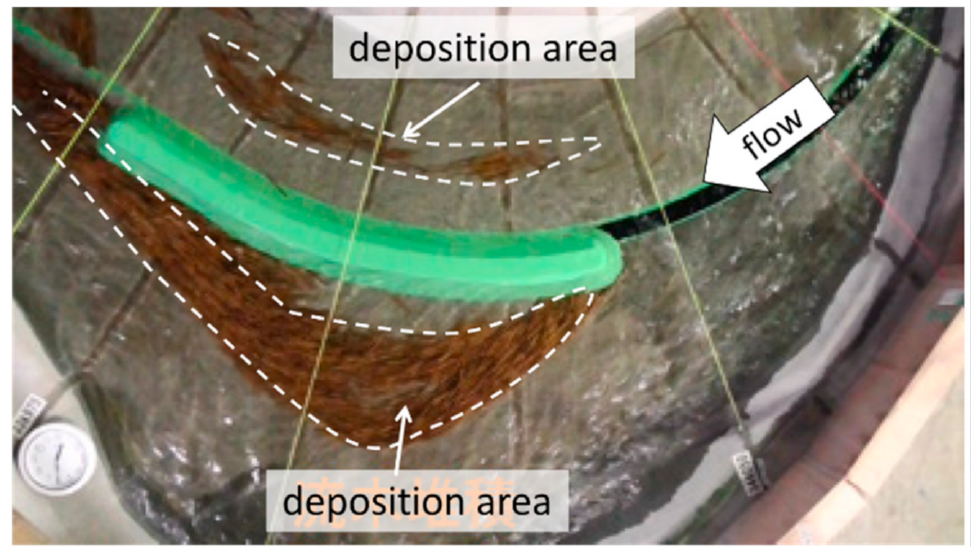
Figure 16. Driftwood deposition area in laboratory experiment. Reproduced with permission from Kato et al., Experimental study on design of driftwood capturing facility in Omoto River; published in Advances in river engineering. JSCE, 2018